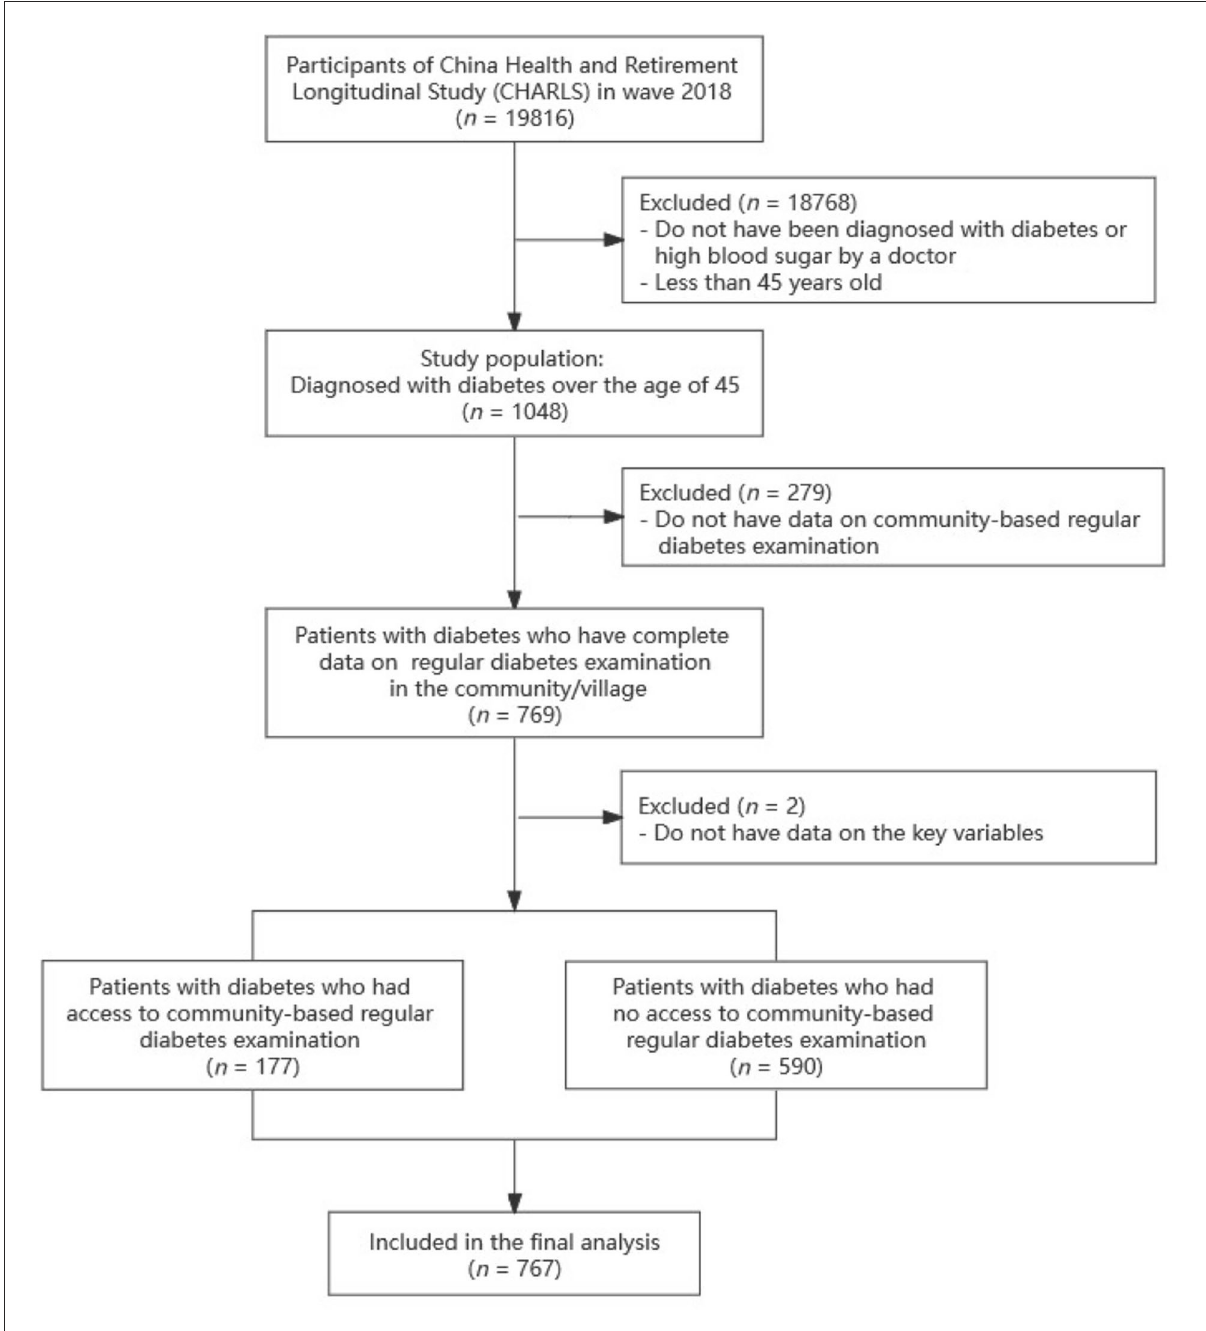
FIGURE1 Process of sample